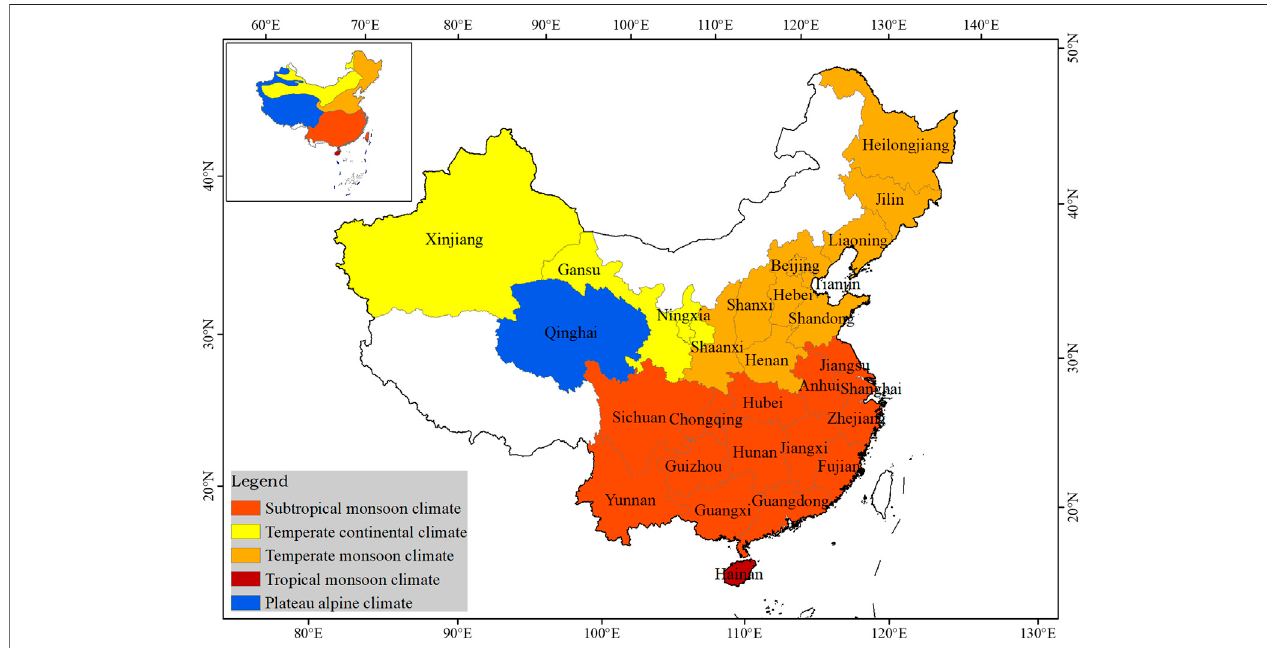
FIGURE 1 | Distribution of five climatic regions for grain yield in China